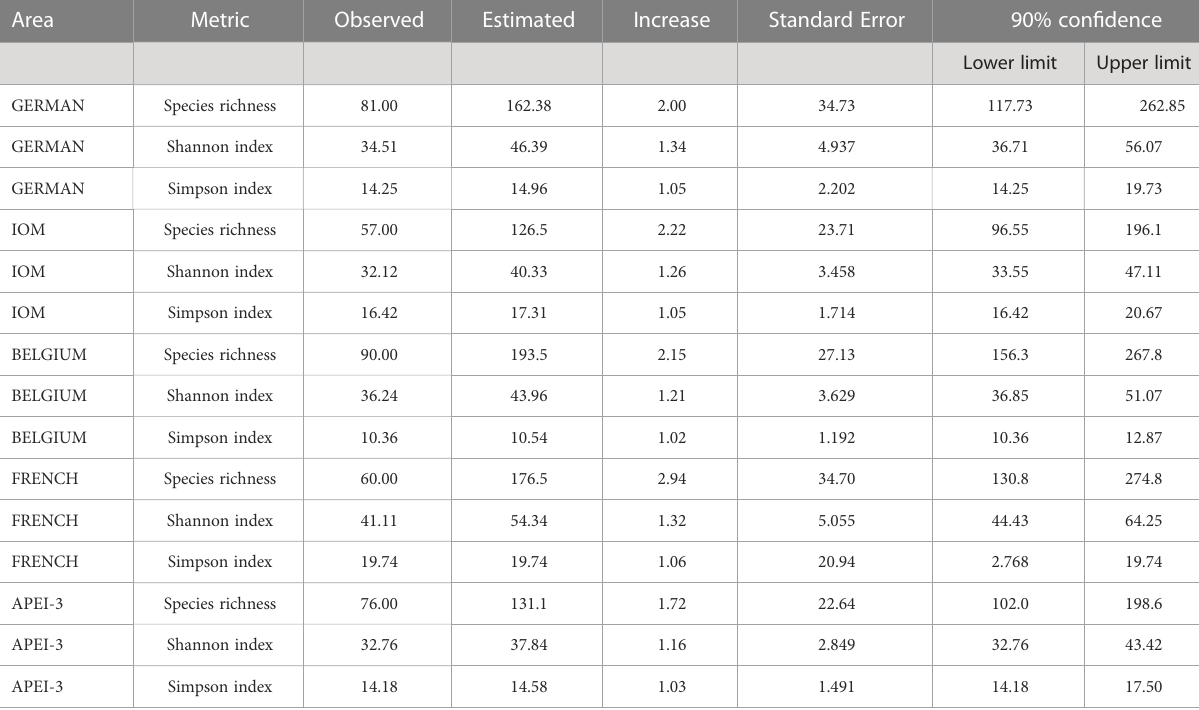
TABLE 4 Observed (actual data) and predicted (assuming full sample representativeness) values of species richness and diversity in the fi ve areas.